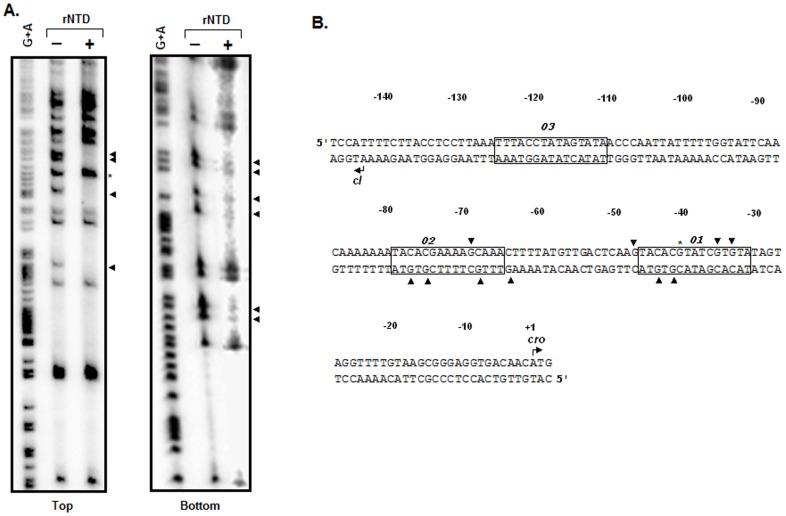
DMS protection assay.(A) Autoradiograms of DMS protection footprints were generated by standard procedures (see Materials and Methods for details) using rNTD (+) or no rNTD (−) and O DNA, which was labeled either on the top (Top) or bottom (Bottom) strand. The arrowhead and star indicate the protected guanine (G) base and hypermethylation site, respectively. (B) Summary of the DMS protection footprints. The sequence of the Φ11 cI- cro intergenic region shows the locations of the three 15 bp O1, O2, and O3 sites (solid boxes). The hypermethylated base and protected G bases, identified in panel A, are indicated by arrowheads and stars, respectively. The start codons of Cro and CI are represented by angled arrows. The whole sequence was numbered considering the first base of the Cro start codon as +1.